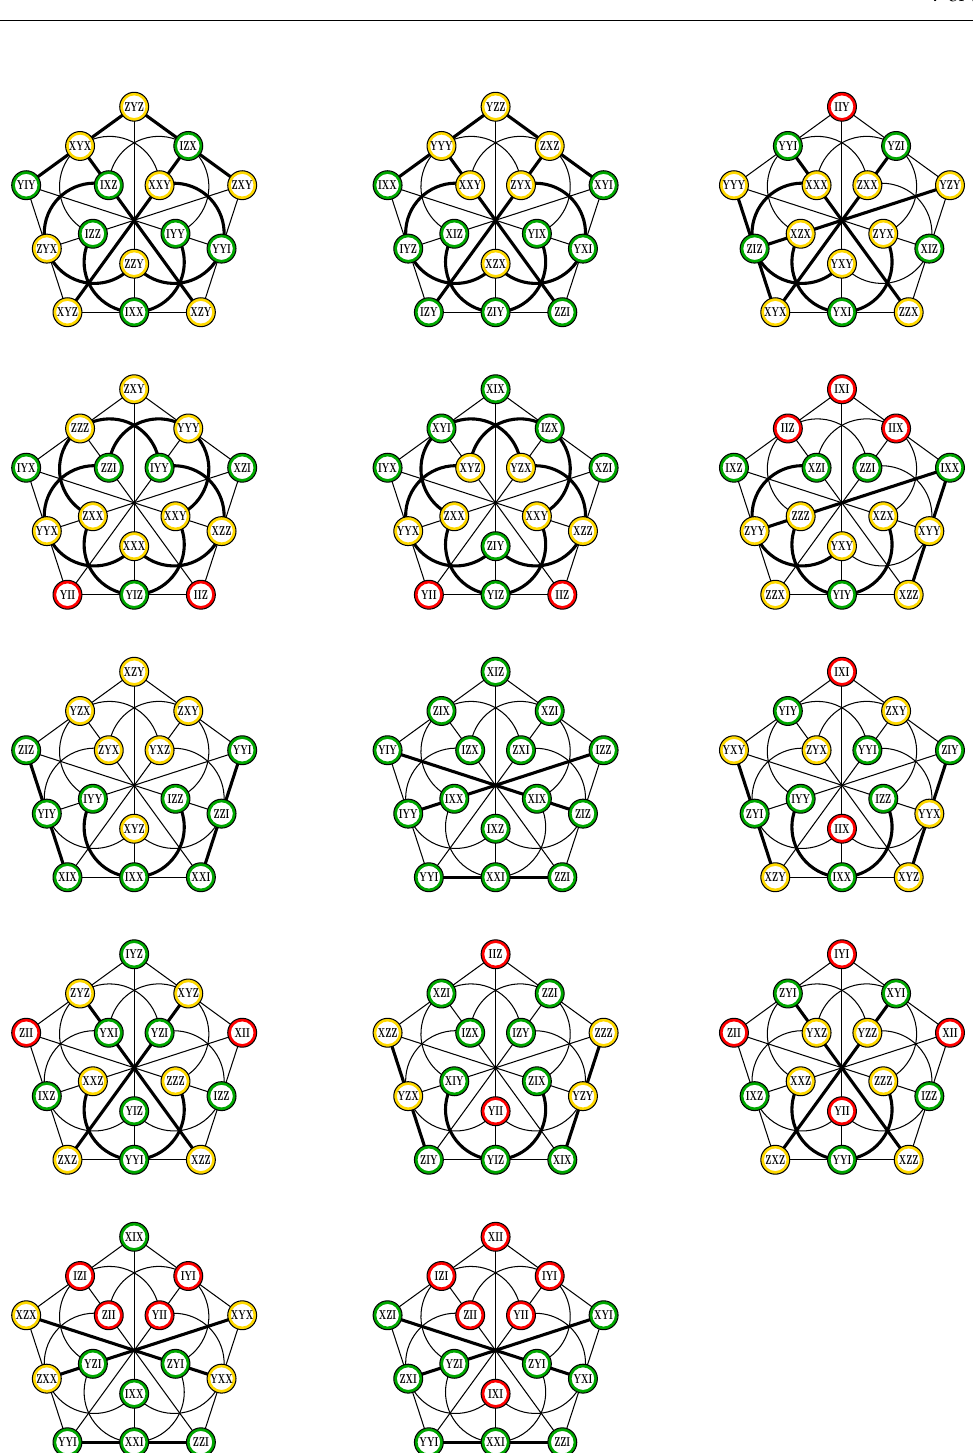
Figure 3. Representatives—numbered consecutively from left to right, top to bottom—of the 13 dif- ferent types of three-qubit doilies; Type 1 is top left, Type 13 bottom middle; we also distinguish between Type 9 A (3rd row, right) and Type 9 B (4th row, left). The three different types of observables are distinguished by different colors and the negative lines are drawn